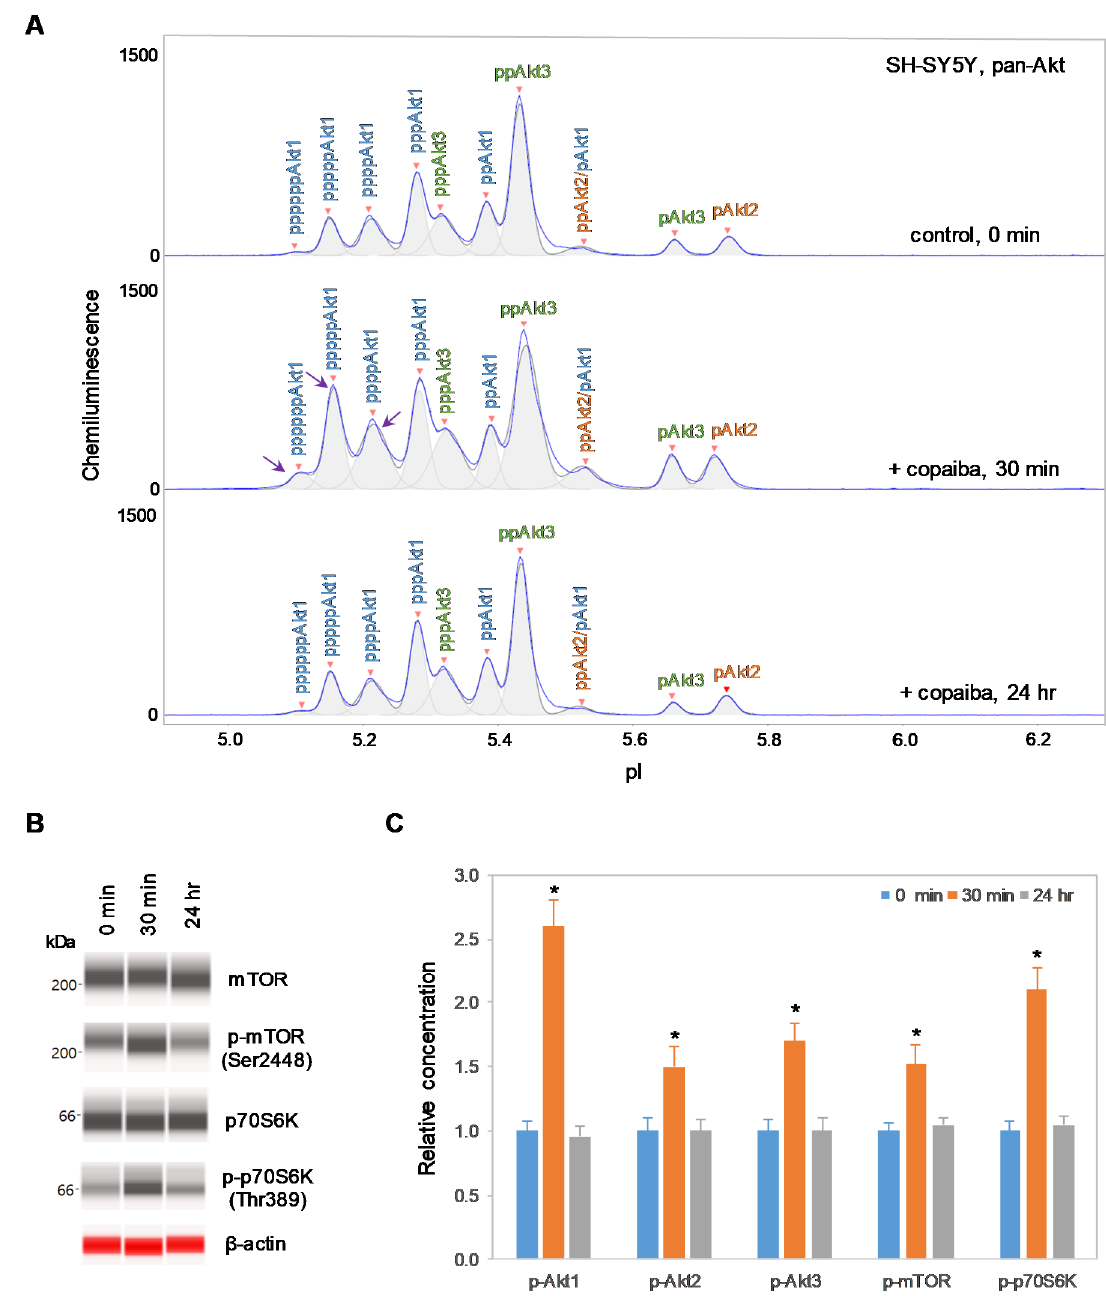
Figure 2. Positive regulation of the pI3K / Akt / mTOR signaling pathway in SH-SY5Y neuronal cells by copaiba essential oil. ( A ) cIEF electropherograms of pan-Akt in SH-SY5Y cells before (0 min) and after (30 min and 24 h) treatment with copaiba essential oil. Peaks associated with Akt isoforms are labeled and color-coded: Akt1 (blue), Akt2 (orange), and Akt3 (green). The purple arrows point to highly phosphorylated Akt1 peaks that transiently increased following treatment with copaiba essential oil. ( B ) Expression levels of the mTOR and p70S6K phosphoisoforms as a function of time after treatment with copaiba essential oil. β -Actin served as the loading control. ( C ) Relative concentrations of Akt1, Akt2, Akt3, mTOR, and p70S6K phosphoisoforms as a function of time after treatment with copaiba essential oil. The relative concentration describes the fold change in the expression level of a protein phosphoisoform after treatment compared to that under the control condition. The error bars indicate the standard deviations of six repeated measurements per experimental condition. The asterisks indicate a statistical significance of p ≤ 0.05 versus the control. SH-SY5Y cells were treated with 100 ng / mL copaiba essential oil.